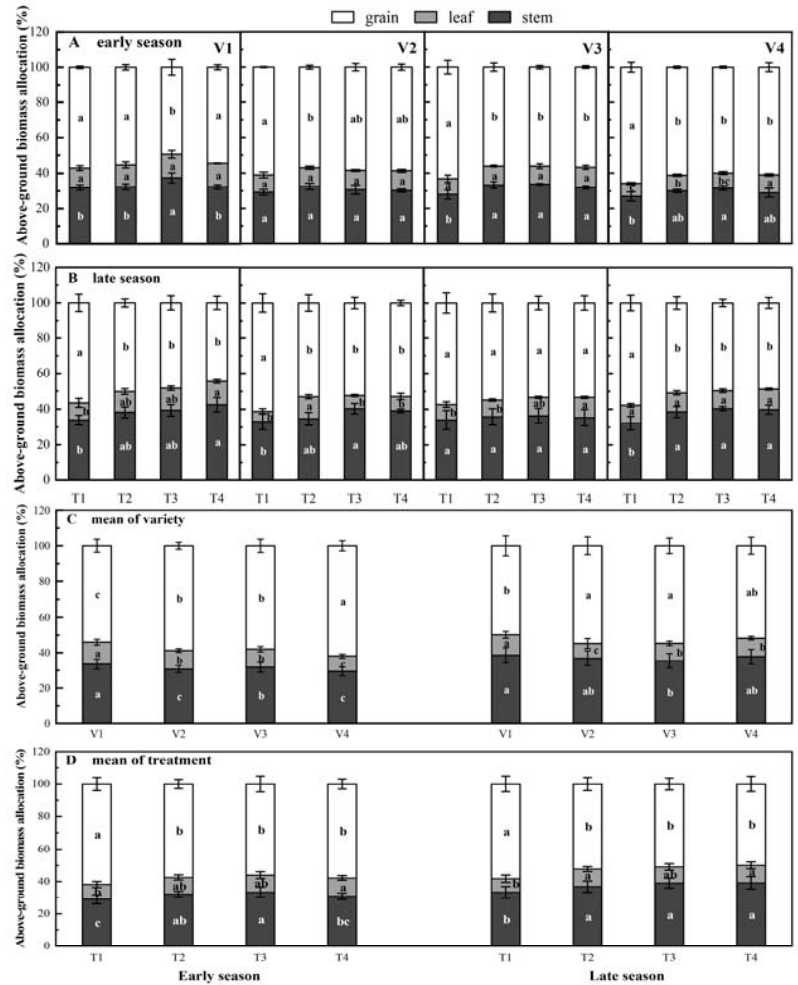
Figure 2. Effects of different treatments on above-ground biomass allocation of early and late season rice. Note: T1, 1 seeding per hill + row spacing 12.93 cm; T2, 3 seedings per hill + row spacing 22.33 cm; T3, 6 seedings per hill + row spacing 31.67 cm; T4, 9 seedings per hill + row spacing 38.80 cm; V1, V2, V3, and V4 represent ‘Guiyu’, ‘Zhenguiai’, ‘Zhuangxiangyou5’, and ‘Yexiangyou2’; different lowercase letters within subgraphs indicate significant differences between treatments ( p < 0.05); The longer the error bars, the greater the variability of the sample data in the group. The grain-to-leaf biomass ratio reflects the plant’s strategy for allocating resources between reproductive and production organs, with higher grain-to-leaf ratios leading to higher yield potential. The grain-to-leaf ratio was significantly affected by variety and treatment (Figure 3). Among the four varieties, V4 in the early season had the highest grain- to-leaf ratio (7.34). The grain-to-leaf ratio of V2 in the late season was the highest (7.42). Among the four treatments, compared with the T4 treatment, the T1 treatment had the largest grain leaves (no significant difference in the early season but a significant difference in the late season). The average grain leaves the ratio of T1 increased by 26.81% and 37.68% in the early and late growing seasons, respectively, compared with T4